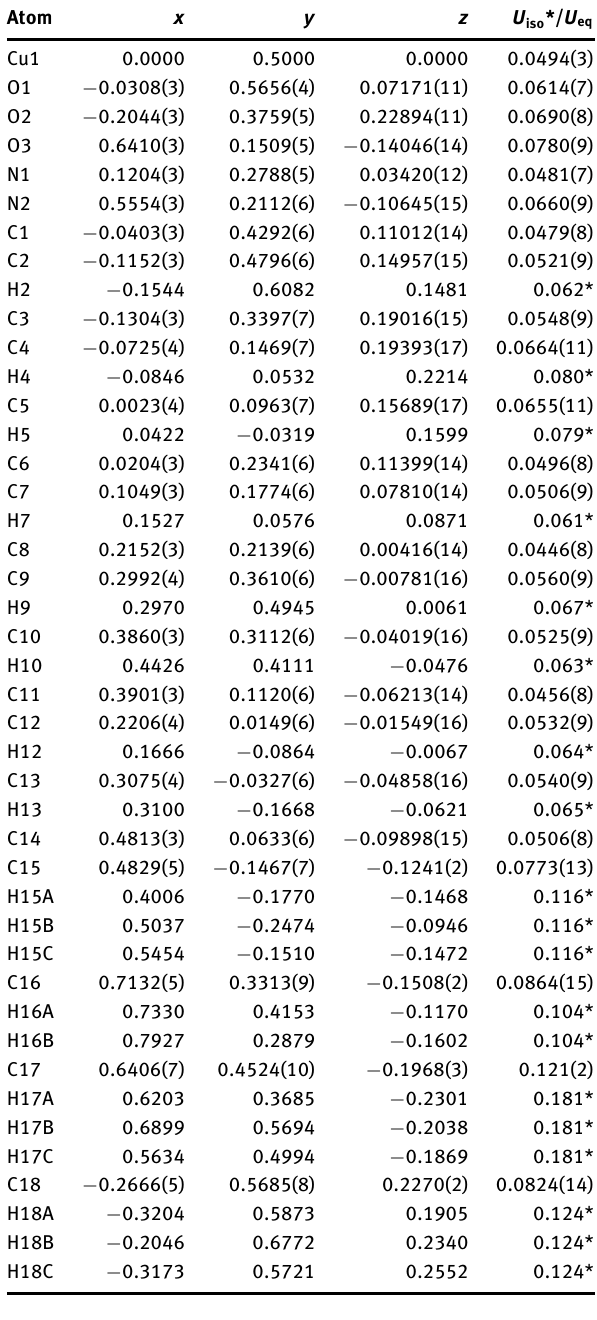
Table 2: Fractional atomic coordinates and isotropic or equivalent isotropic displacement parameters (Å 2